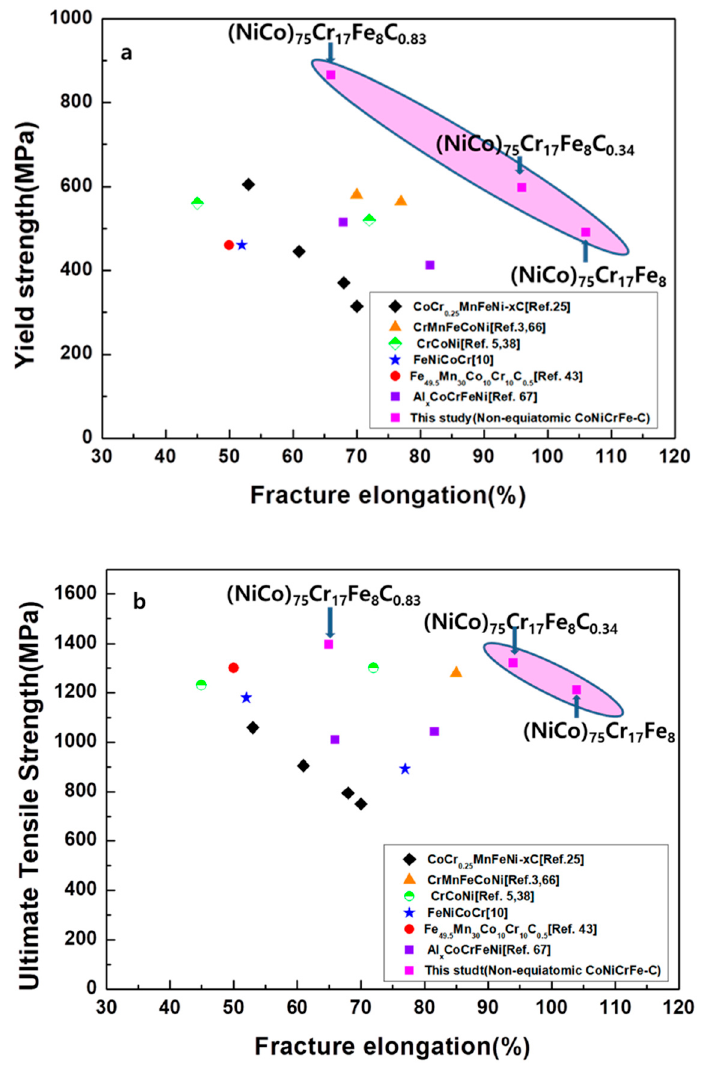
Figure 11. Yield strengths ( a ) and tensile strengths (b) of (NiCo)75Cr17Fe8Cx are plotted against the ductility at cryogenic temperature along with the data of other HEAs